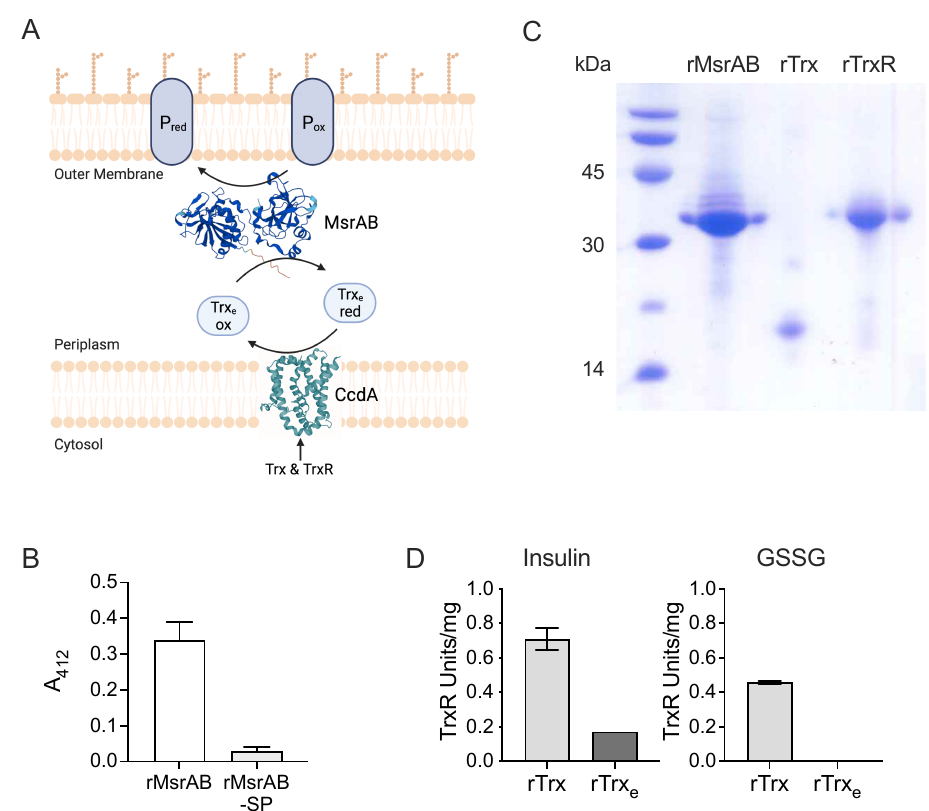
Figure 1. Properties of H. influenzae MsrAB and accessory redox proteins ( A ) Schematic representation of the MsrAB reaction cycle. P ox , P red —generic oxidised or reduced protein, TrxR—Thioredoxin Reductase, Trx—thioredoxin, Trx e —extracellular thioredoxin ( B ) Activity of rMsrAB and rMsrAB-Sp in an endpoint activity assay ( C ) Purified components of rMsrAB activity assay ( D ) Activity of the redox rMsrAB assay thioredoxin-based redox module using either insulin or oxidised glutathione (GSSG) as the artificial substrate. rMsrAB—recombinant methionine sulfoxide reductase activity, rTrxR—recombinant thioredoxin reductase, rTrx—recombinant thioredoxin, rTrx e —recombinant extracellular thioredoxin. Structural representations of MsrAB and CcdA (Panel A) are based on Alphafold database models. Panel A was generated using